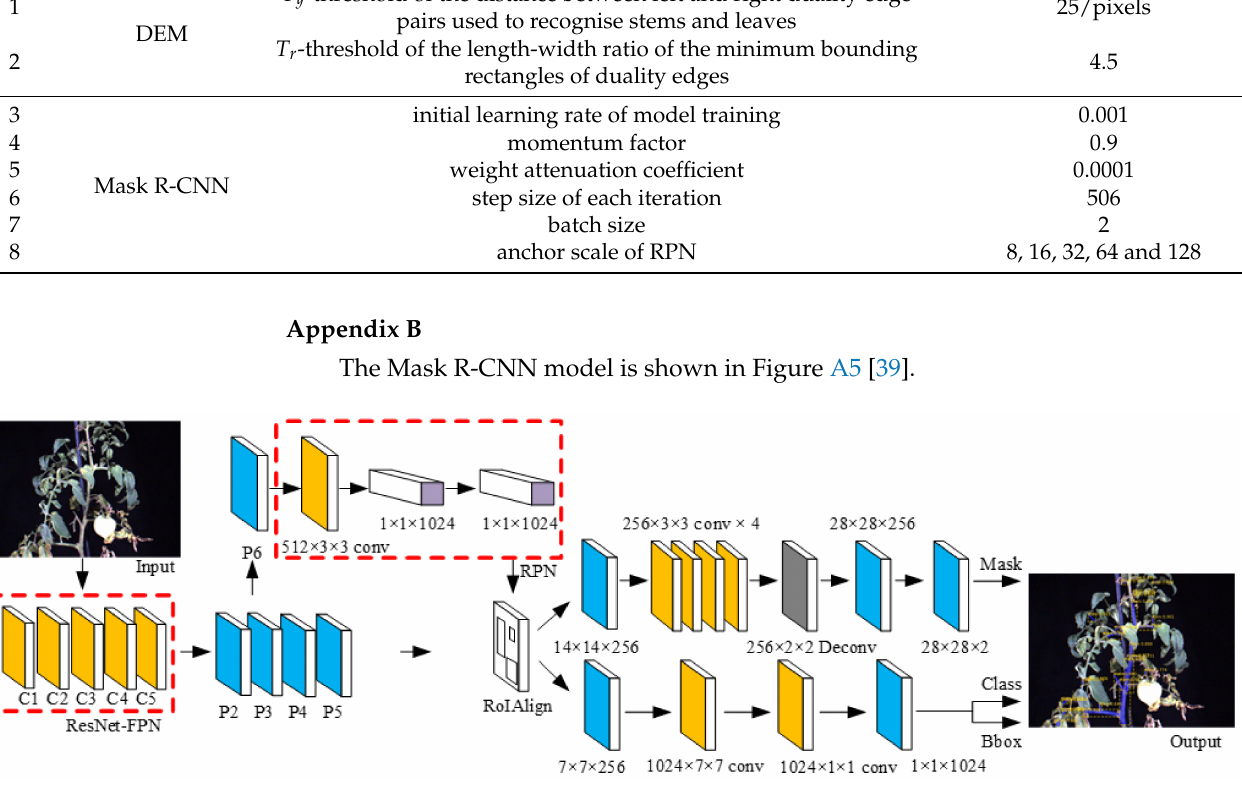
Figure A5. Model of Mask